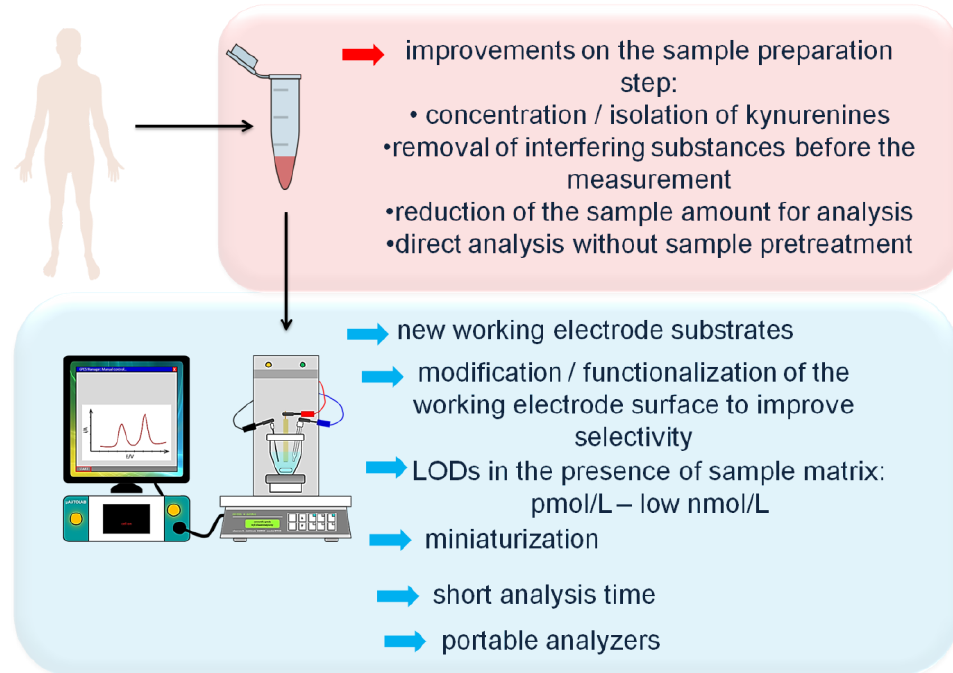
Figure 4. Future research direction in the field of electrochemical determination of kynurenine path- way metabolites in biological samples.